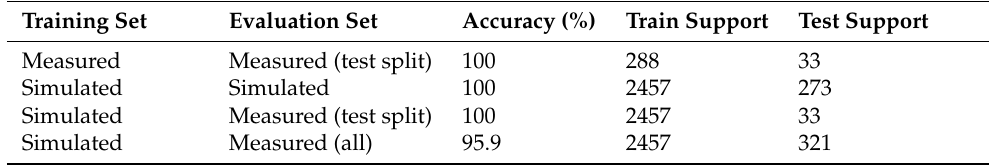
Table 2. Consistent classification results are found when using different measured, and simulated data splits. Seeing similar performance using simulated data as the training set provides validation that the simulations replicate the measured failures well. With this validation, future work will focus on including more failures in the classifier’s